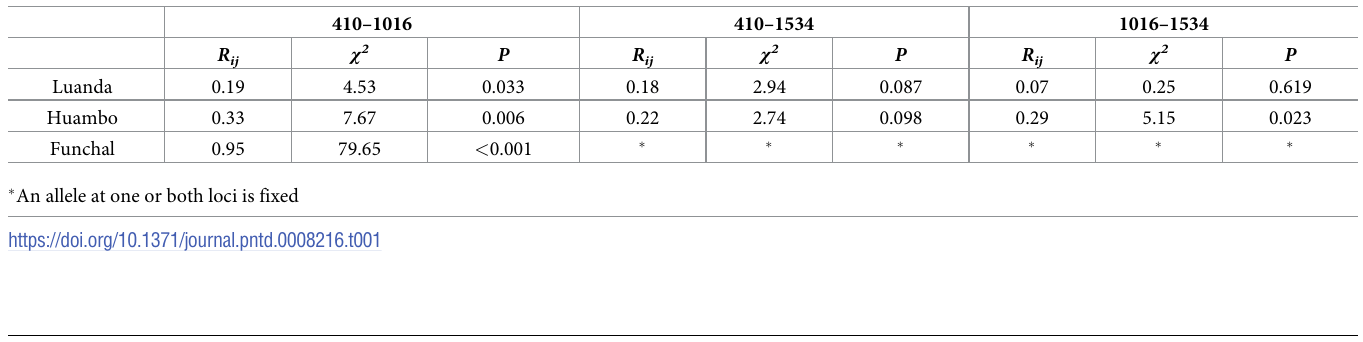
Table 1. Linkage disequilibrium coefficients ( R